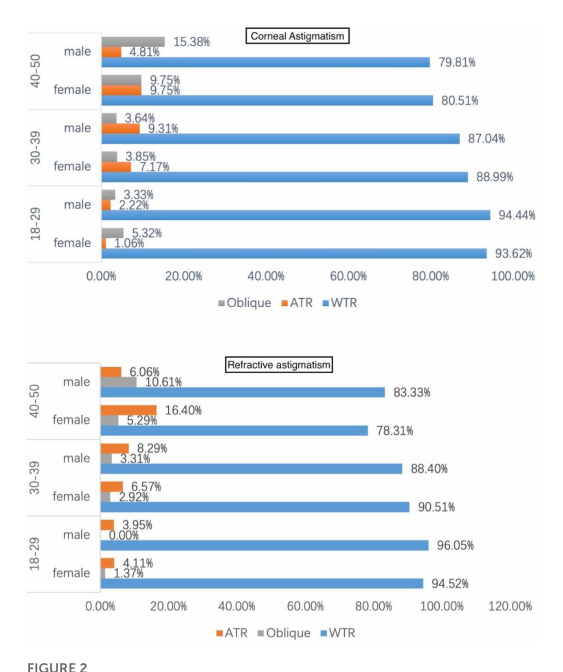
FIGURE2 Distribution of astigmatism axis stratified by gender and age. WTR, with-the-rule; ATR, against-the-rule.